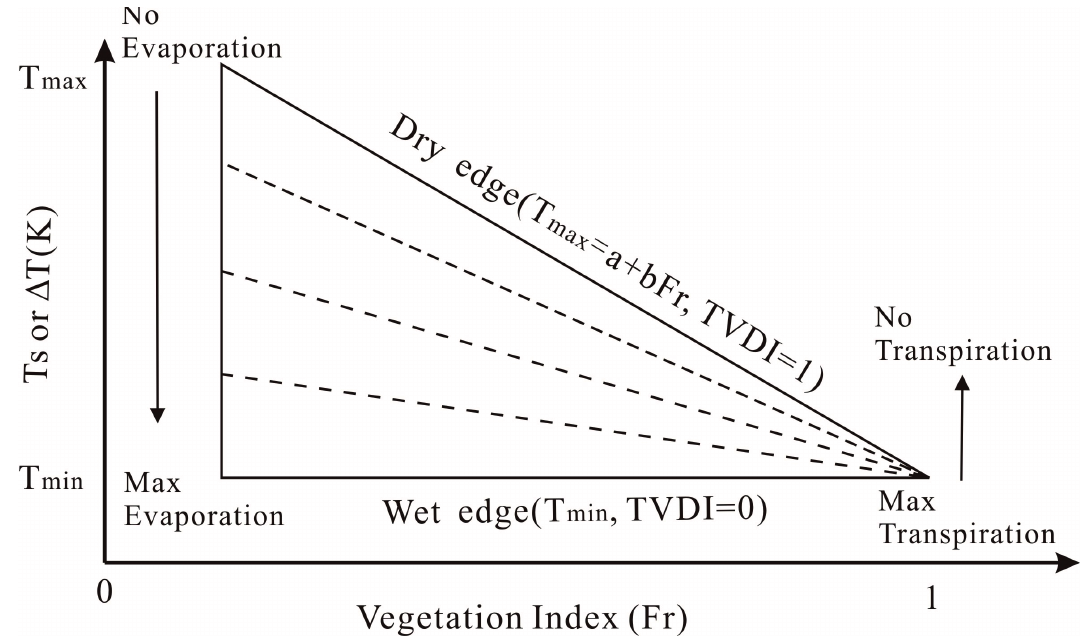
Figure 3. Conceptual diagram of the Ts–VI triangle for determining the